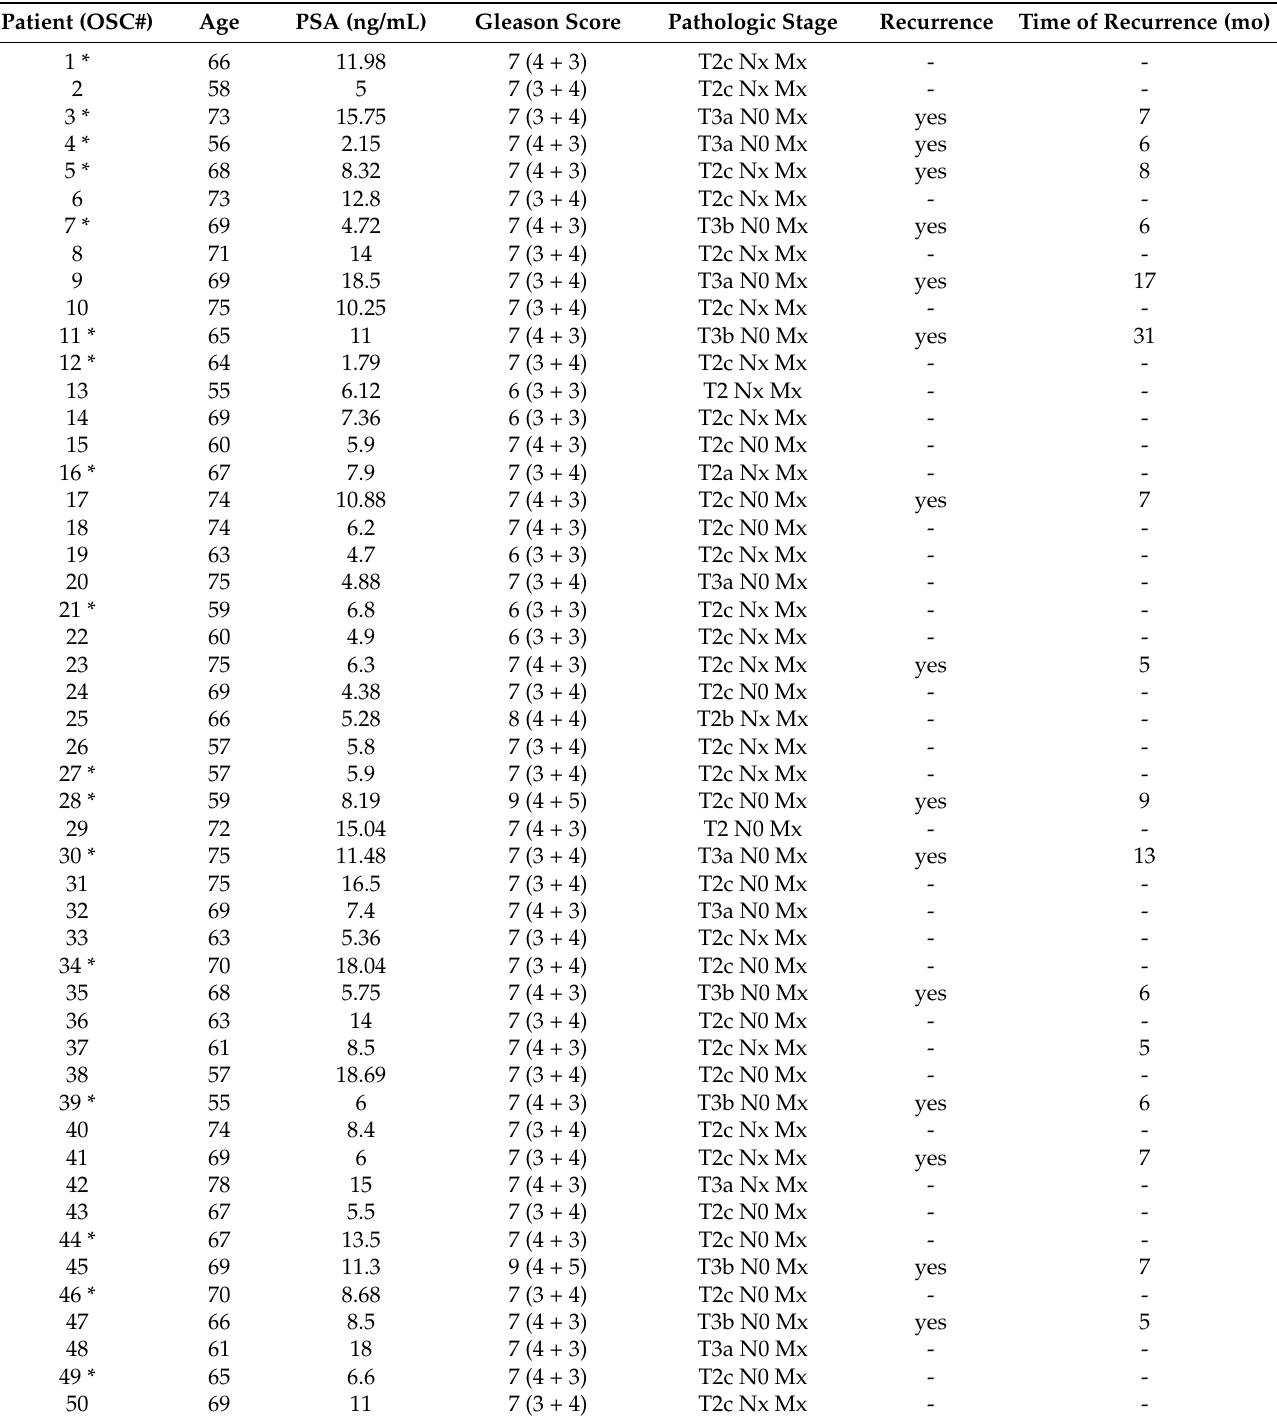
Table 1. Clinical and histopathologic features of patients and their